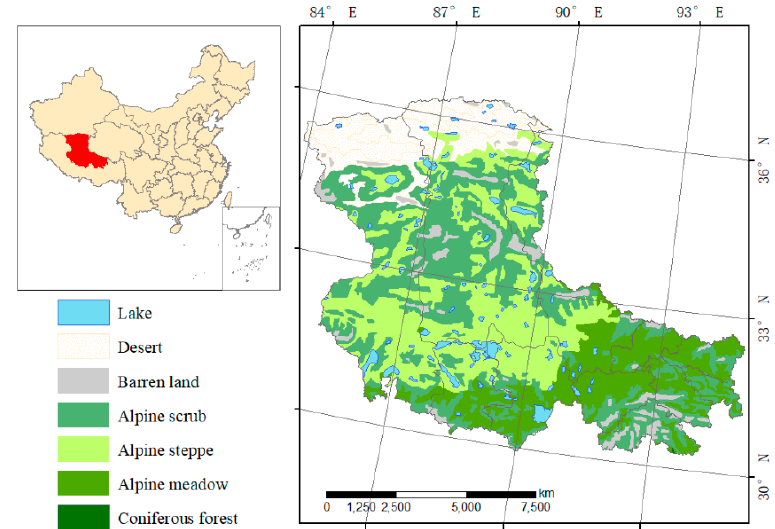
Figure 1. Location of the study area. Vegetation type data of northern Tibet were obtained from the Vegetation Map of China (1:1,000,000), provided by the Data Center for Resources and Environmental Sciences, Chinese Academy of Sciences (RESDC) (http://www.resdc.cn).